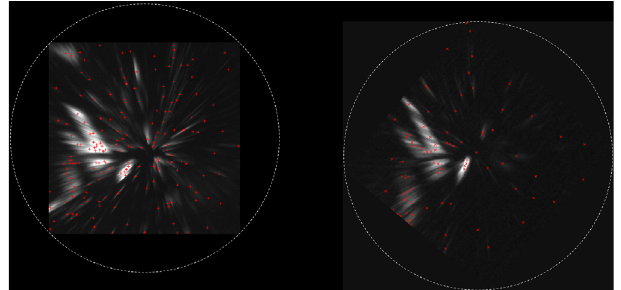
gradient.FIG. 5. Comparison between emission patterns on YAG3 at 70 MV = m taken in Phases 1 (left) and 2 (right, rotated CCW by 50 deg). The images are placed with respect to the origin: since there is slight y offset in the left image, the right rotated image rests below against the left